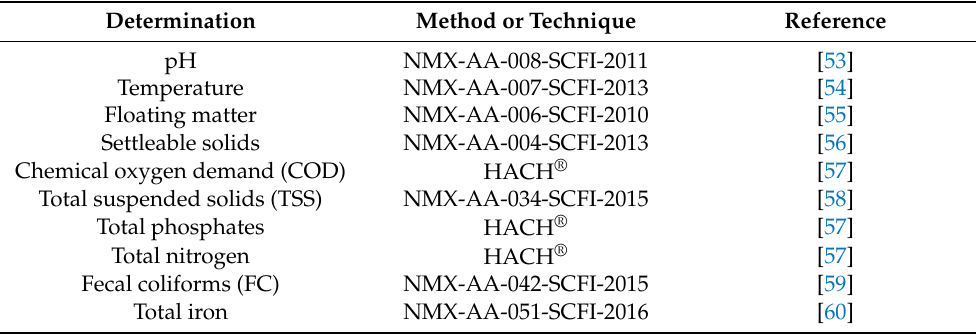
Table 2. Methods and techniques used for the physicochemical characterization of real wastewater sampled and treated by the advanced Fenton oxidation